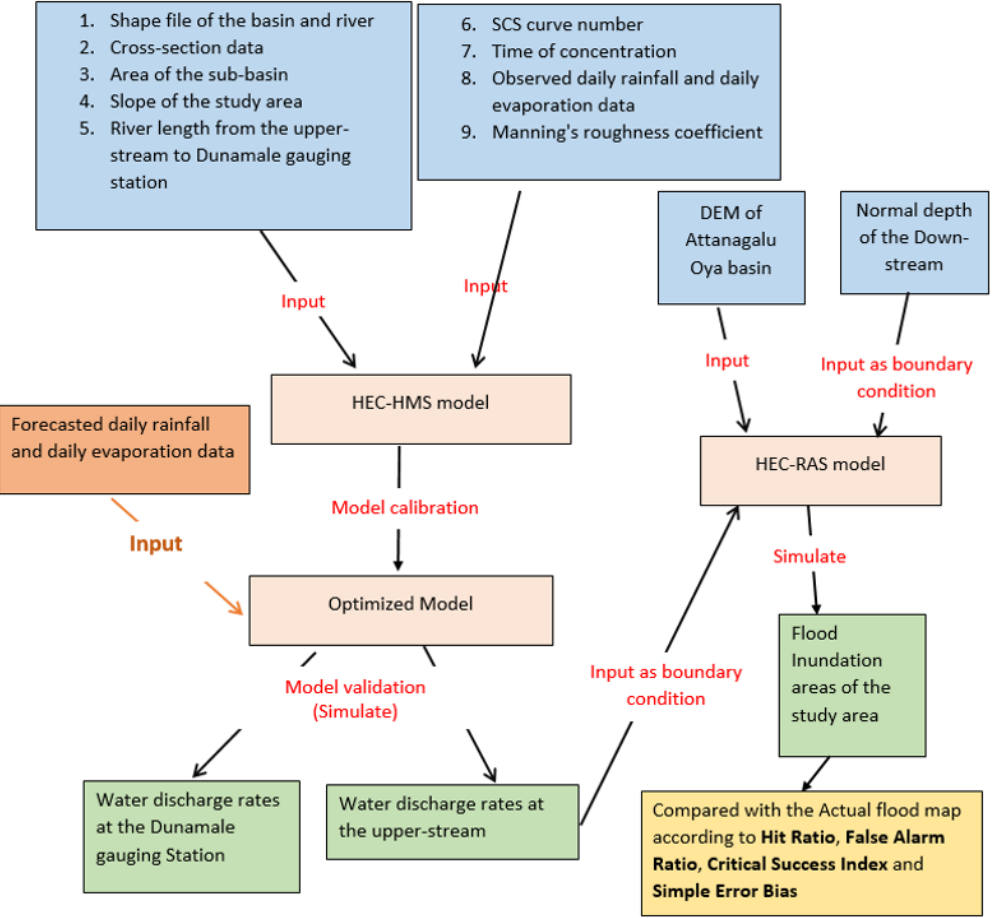
Figure 2: Summary of the